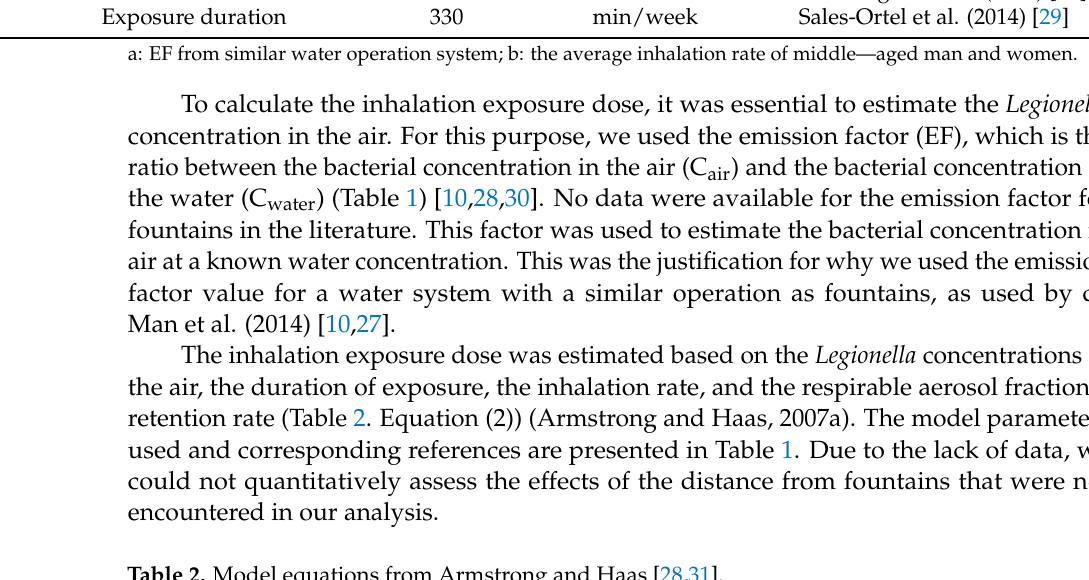
Table 2. Model equations from Armstrong and Haas